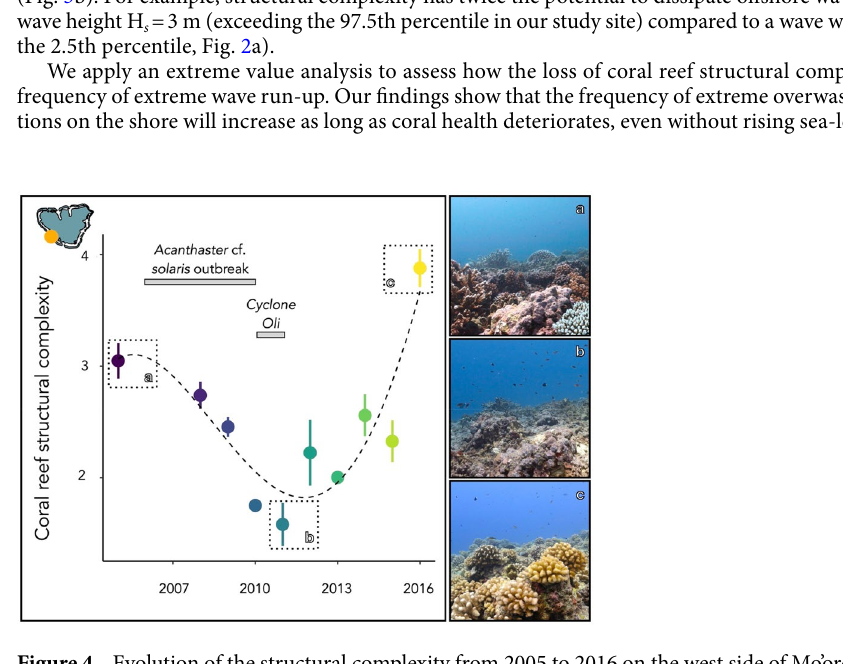
Figure 4. Evolution of the structural complexity from 2005 to 2016 on the west side of Mo’orea (French Polynesia). Perturbations included a predatory sea star ( Acanthaster cf. solaris ) outbreak from 2006 to 2009 and a cyclone in February 2010. Photographs illustrate the reefscapes in ( a ) 2005, ( b ) 2011 (unhealthy reef) and ( c ) 2016 (healthy